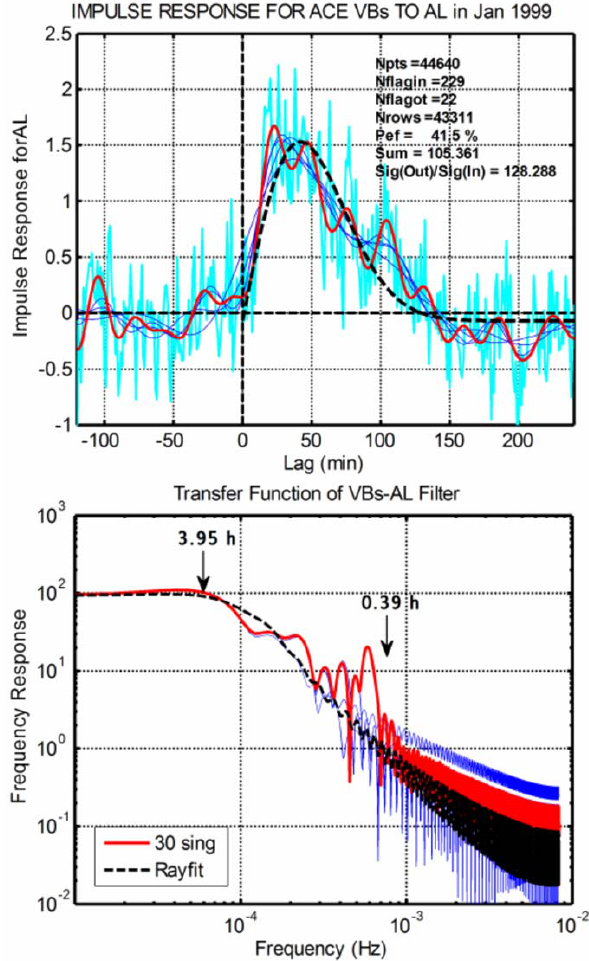
Fig. 3. The V B s -AL prediction filter for the month of January 1999 Figure 3. The VBs-AL prediction filter for the month of January and its frequency and its frequency response are plotted in the upper and lower panels response are plotted in the upper and lower panels respectively. The heavy dashed lines respectively. The heavy dashed lines in the two panels show the fit show the fit of a Rayleigh function to the filter and its transform (see text for details). of a Rayleigh function to the filter and its transform (see text for